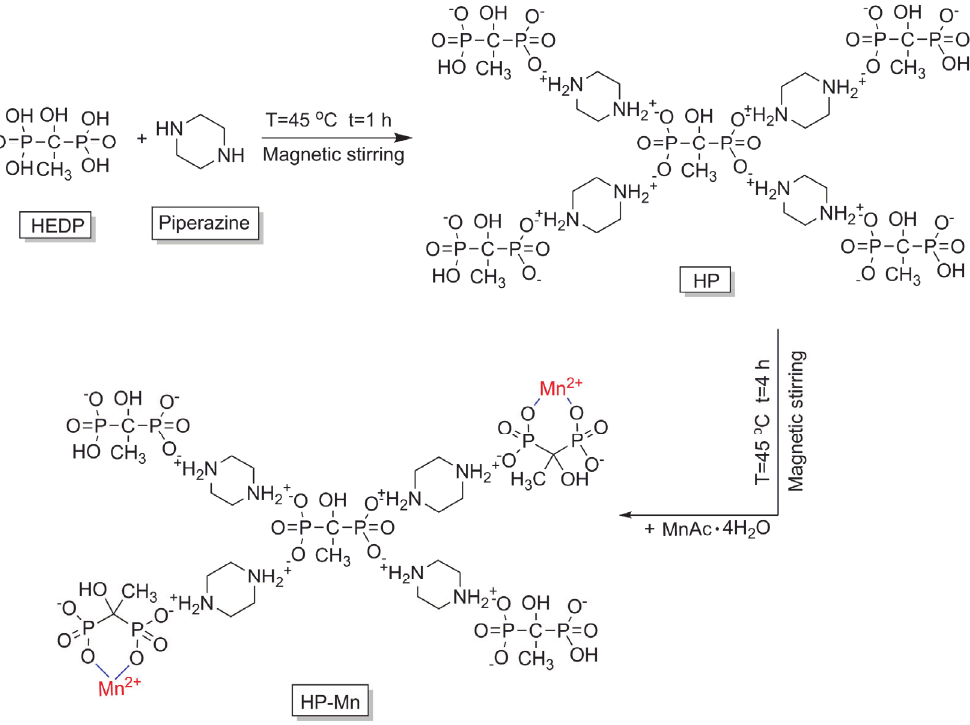
Figure 1. The synthetic route of HP-Mn.